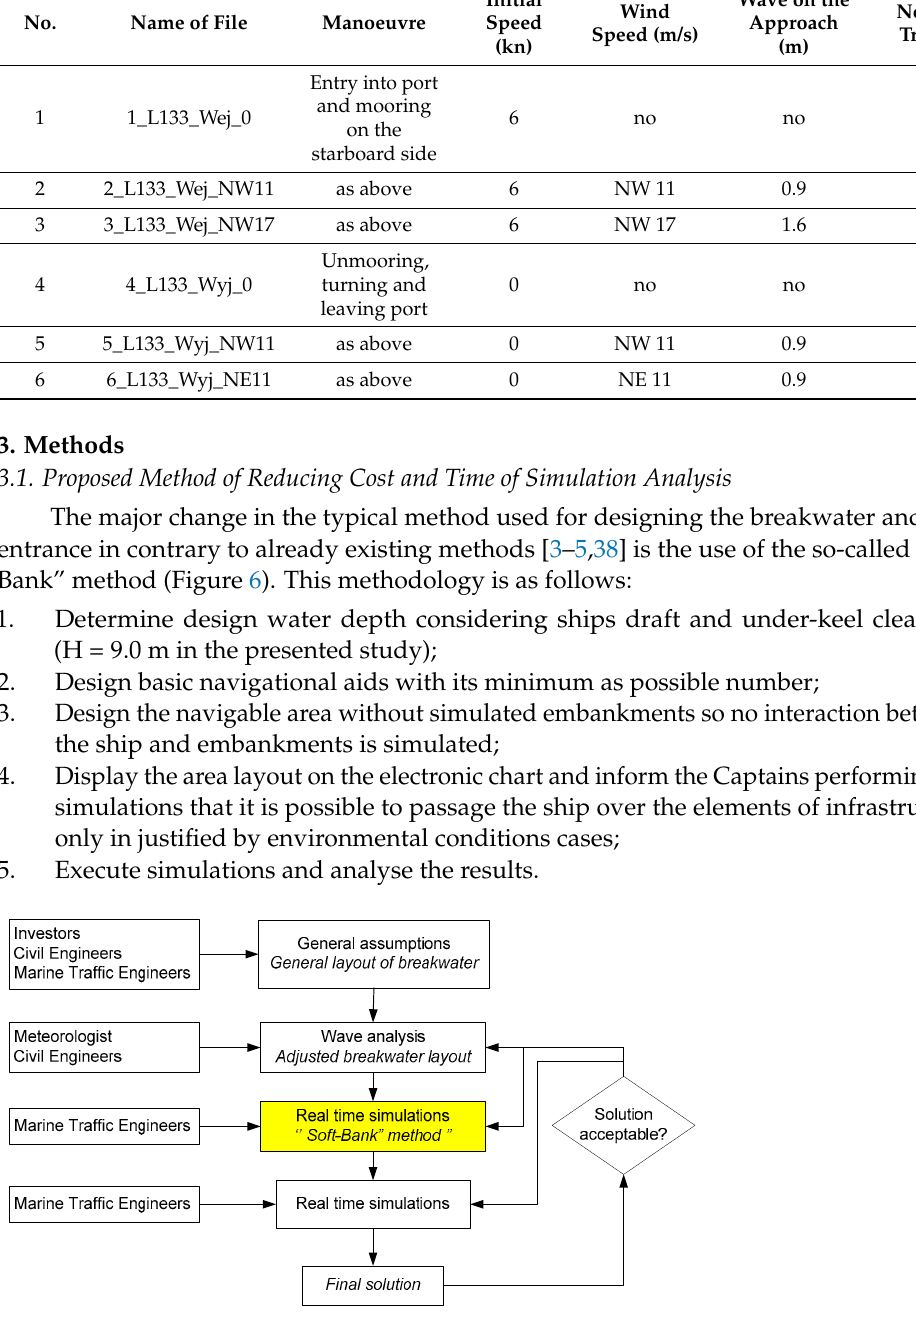
Figure 6. The flowchart of the new method of port approach area design applied in this study.